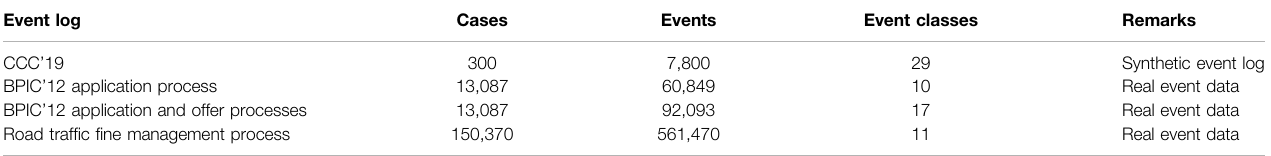
TABLE 4 | Details of the event data used in the experimental evaluation. Event log